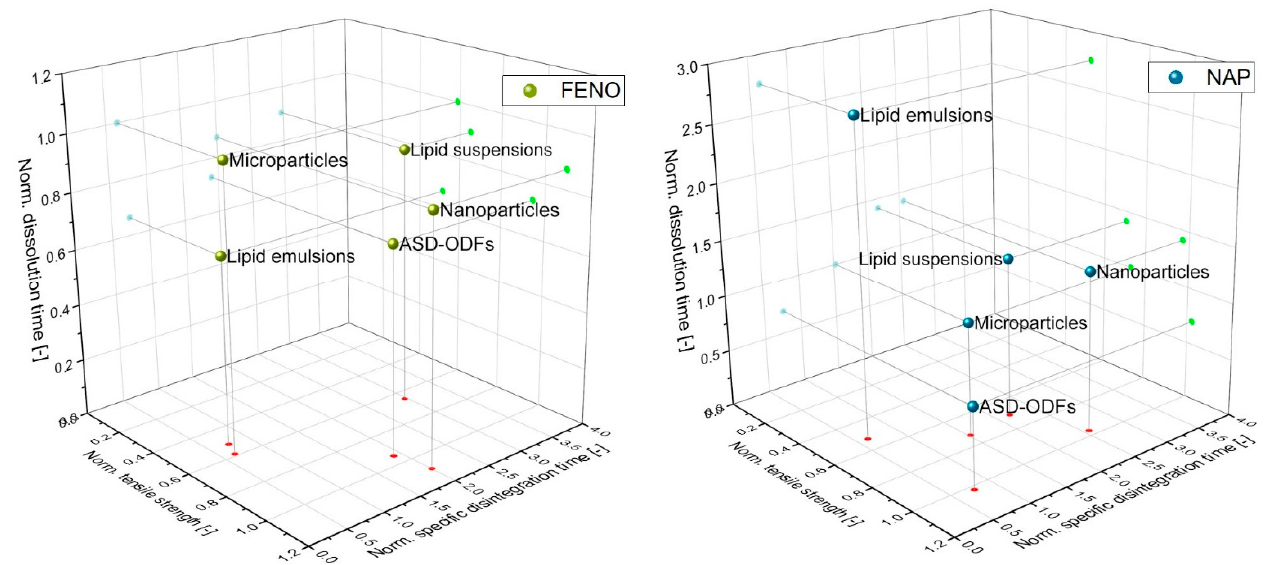
Figure 11. Comparison of the influence of film formulations with the normalized film properties tensile strength, specific disintegration time and dissolution time (Q = 80 %); FENO-containing ODFs ( left ), NAP-ODFs ( right ).